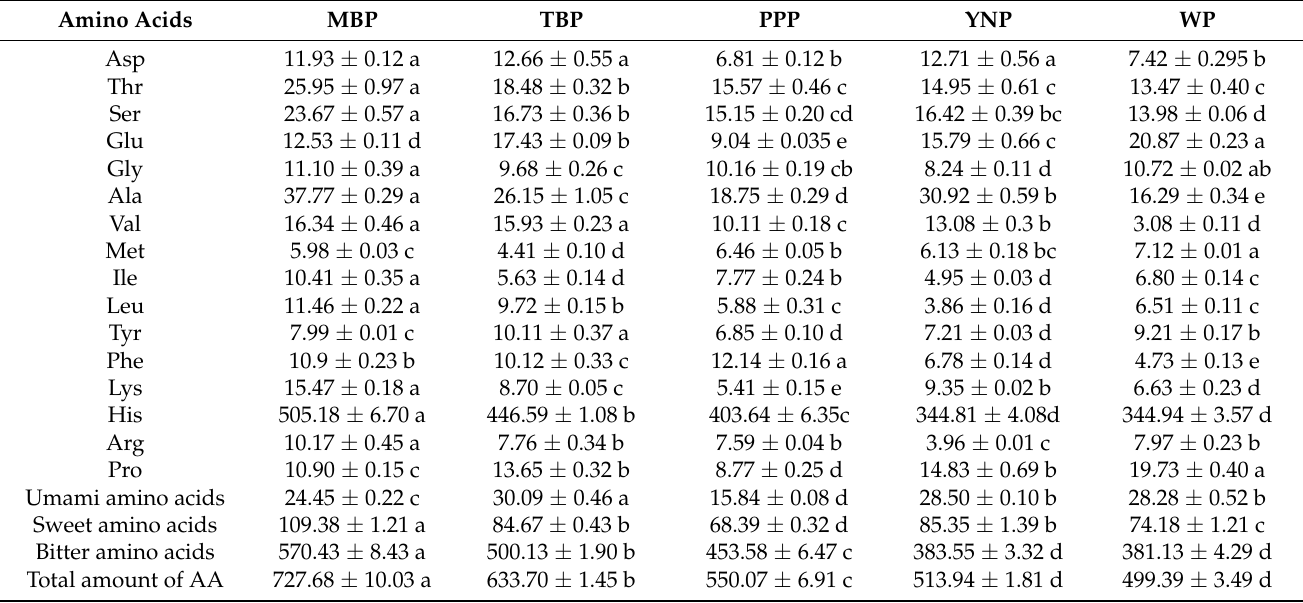
Table 8. Contents of free amino acids of pork (mg/100